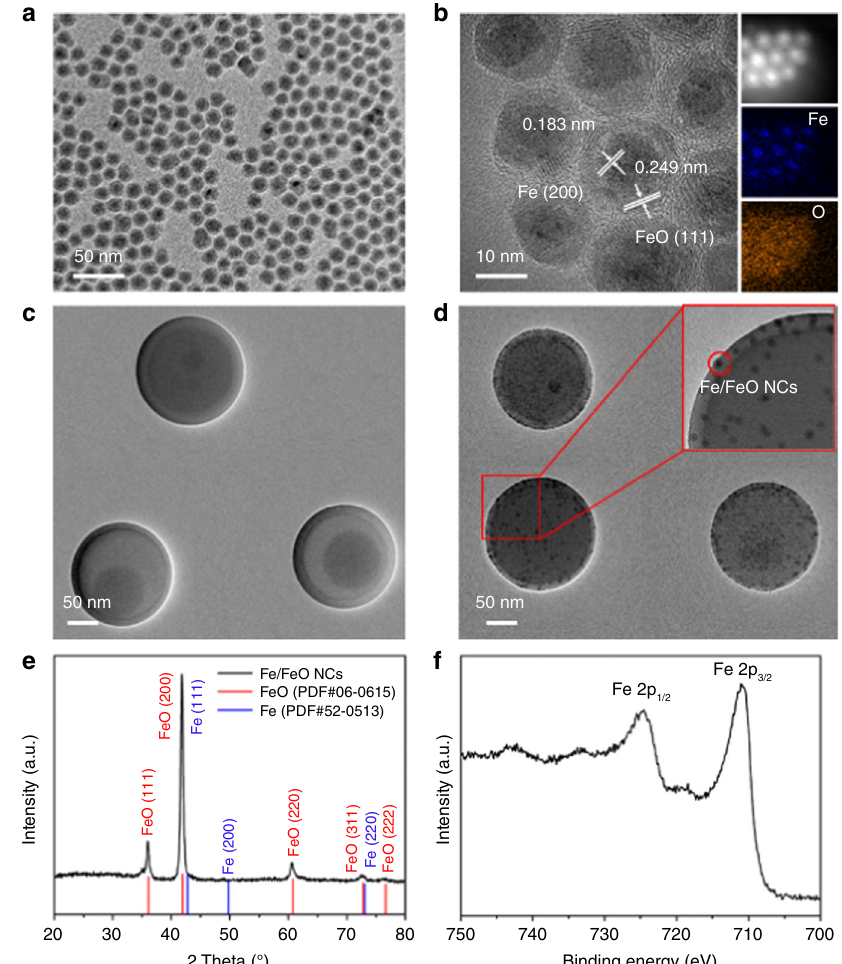
Fig. 2 Characterization of DOX – ICG@Fe/FeO – PPP nanocapsules. a TEM image of Fe/FeO NCs. b HRTEM image of Fe/FeO NCs, inset: EDS-mapping of Fe/FeO NCs. c TEM image of DOX – ICG@PPP nanocapsules, d TEM image of DOX – -ICG@Fe/FeO – PPP nanocapsules. Inset: HRTEM image